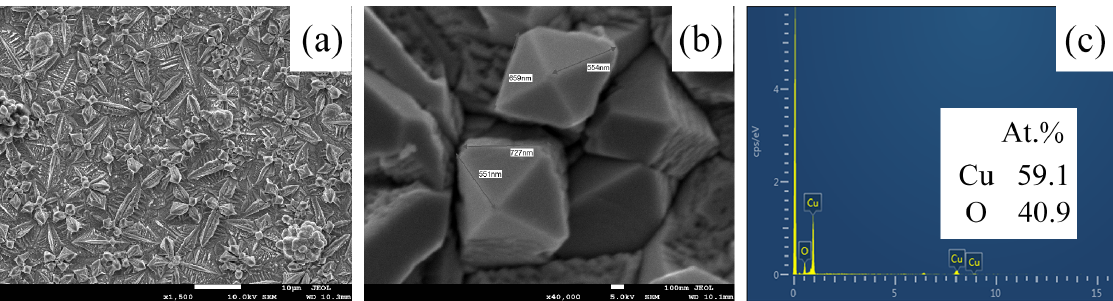
Figure 4. SEM image of Cu/NPSS ( a ), magni fi cation image of the Cu/NPSS ( b ) and the correspond- ing atomic ratios of elements of the Cu/NPSS ( c ).